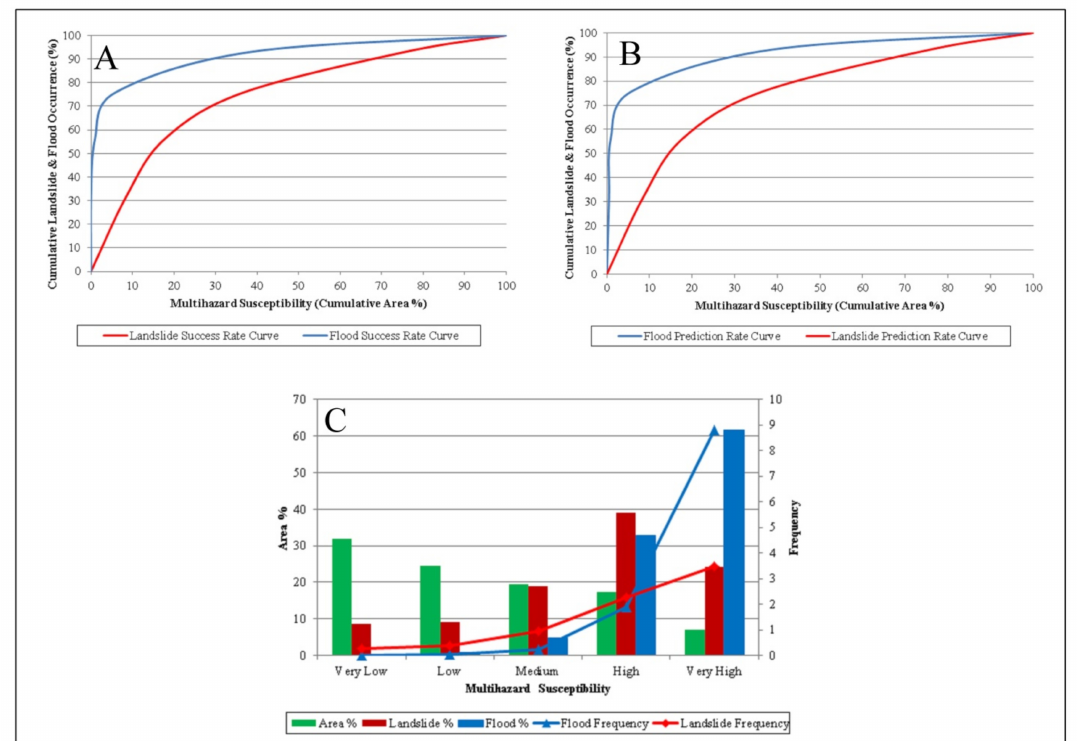
Figure 15. Validation of the multi-hazard susceptibility models. ( A ): Success rate curve, ( B ): prediction rate curve, and ( C ): frequency